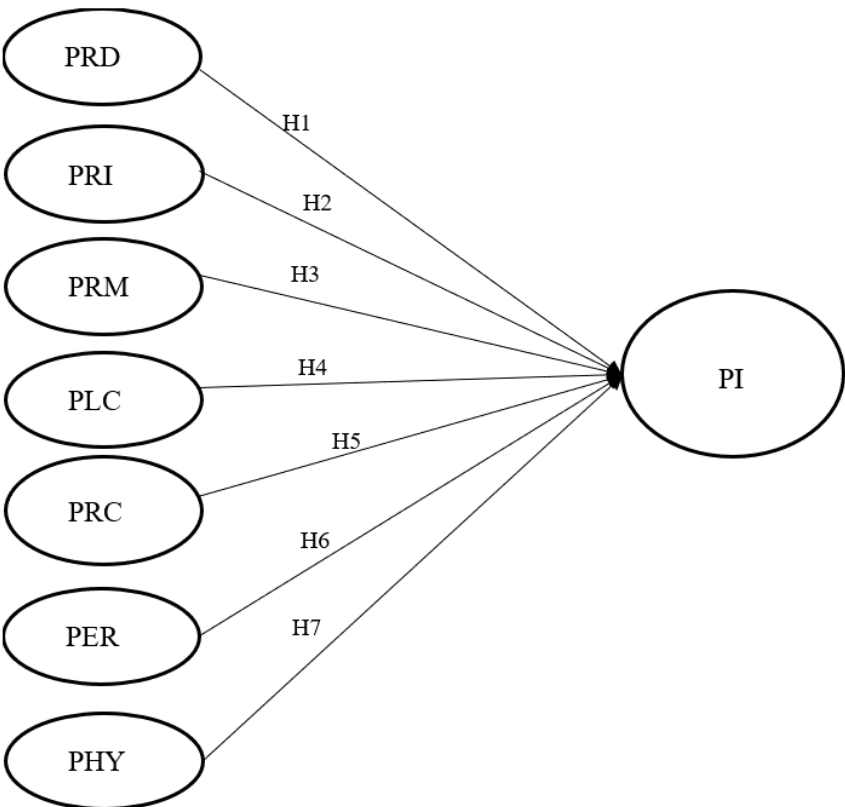
Figure 1. Research framework for testing customers’ purchase intention (Model 1). Note: Please refer to Appendix A Table A1 for the abbreviations of the constructs.